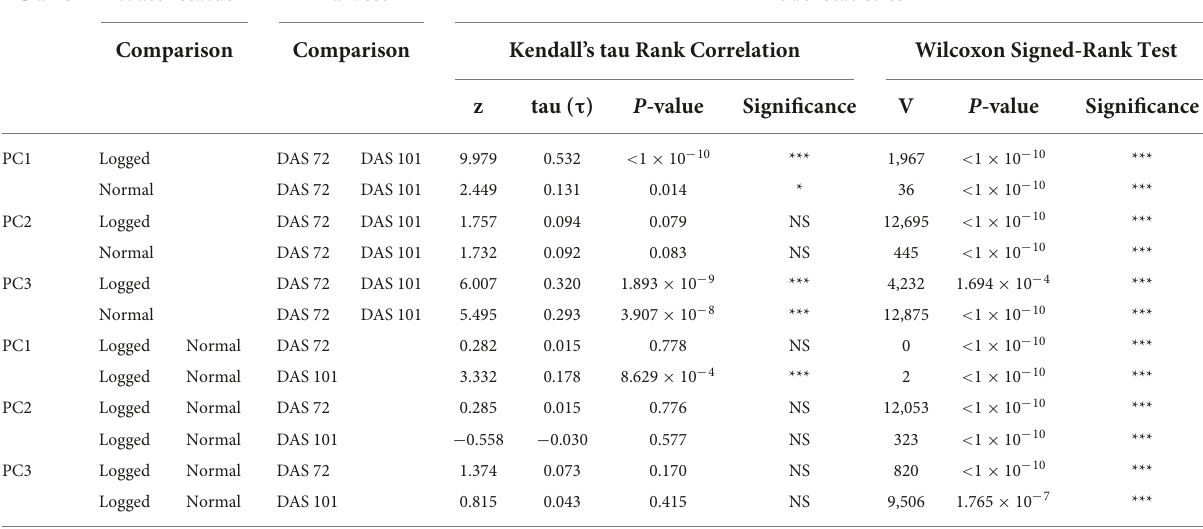
TABLE 3 Model statistics and significance levels for the comparison of PC axes values for the groupings harvested material (DAS 72 and 101) and water status of the cores in contrast to the other